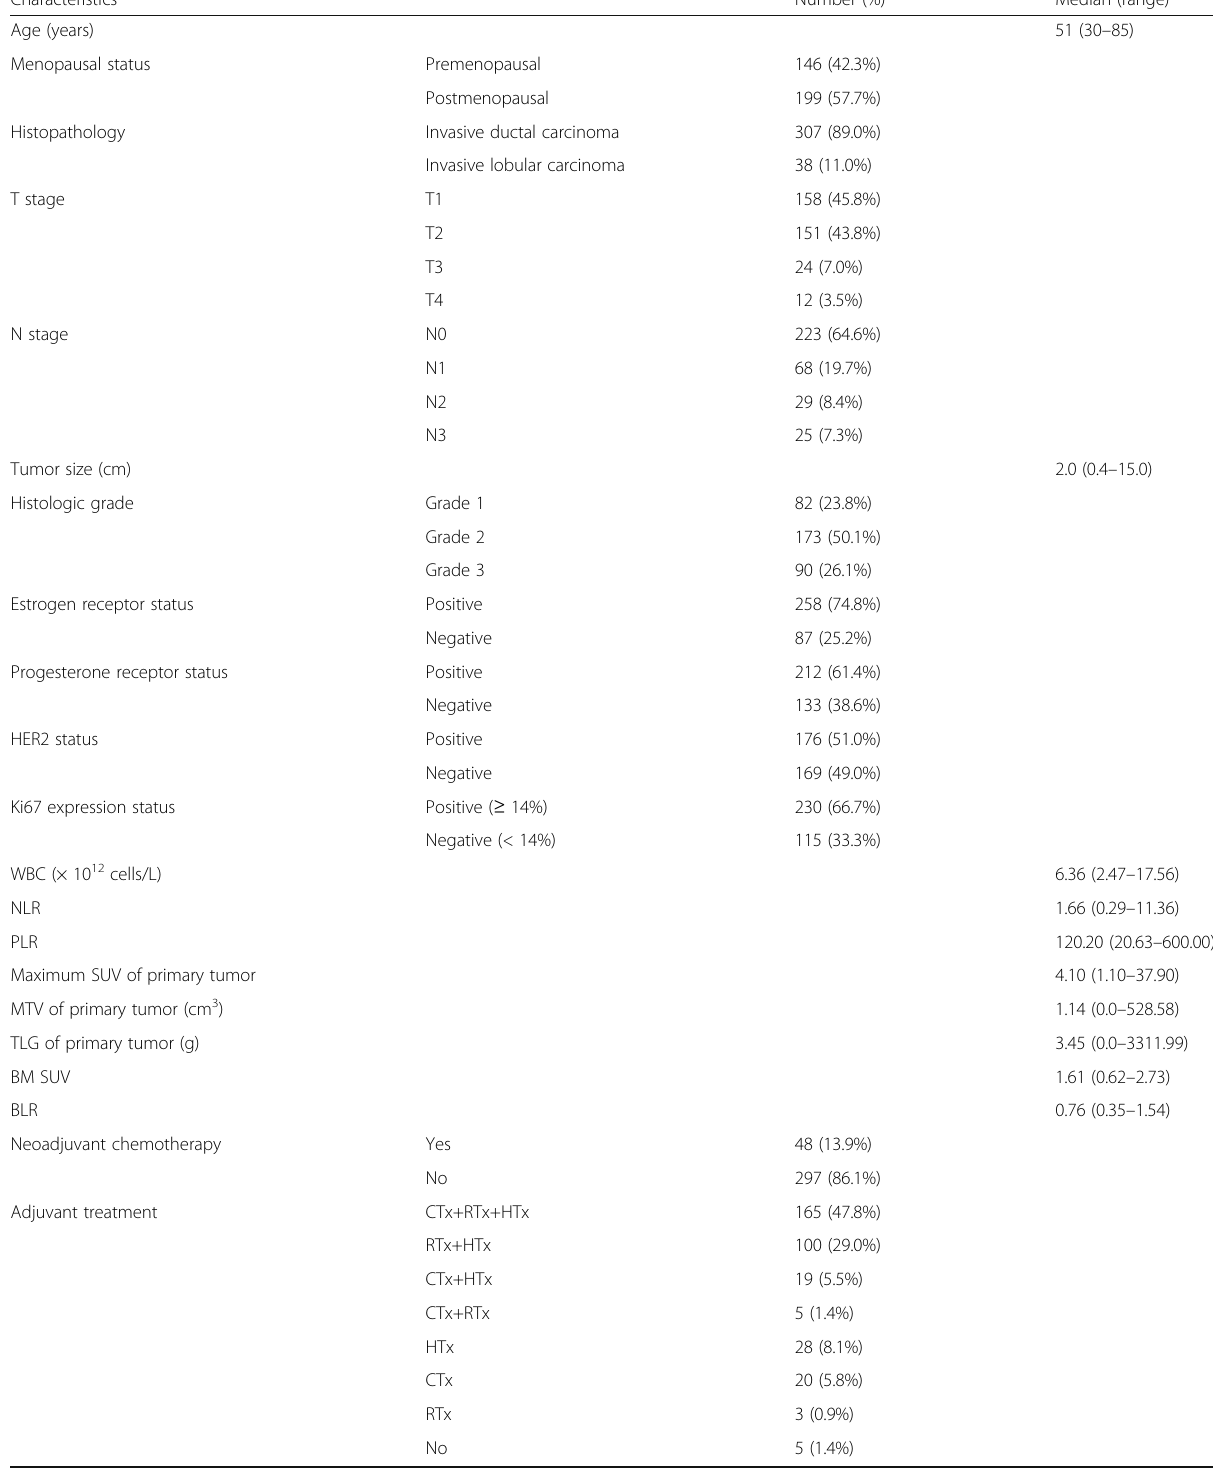
Table 1 Characteristics of 345